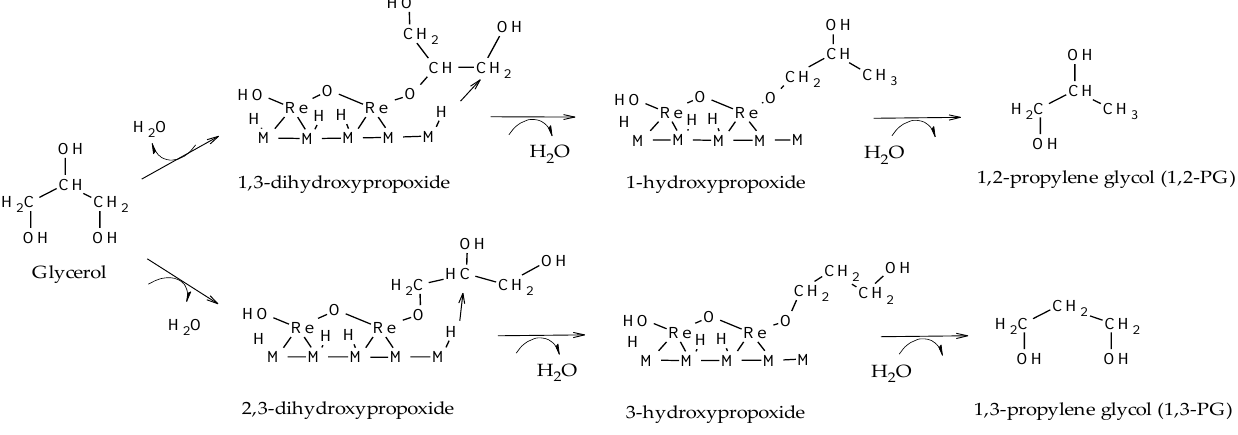
Scheme 17. The direct mechanism of hydrogenolysis over M-ReO x (M = Ir, Rh) catalysts. Guan et al. employed Ir-ReO x /ZrO 2 catalysts and DFT calculations that allowed